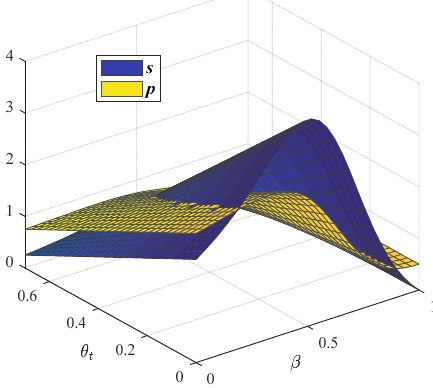
Figure 4. Pricing and service decisions in Scenario U.